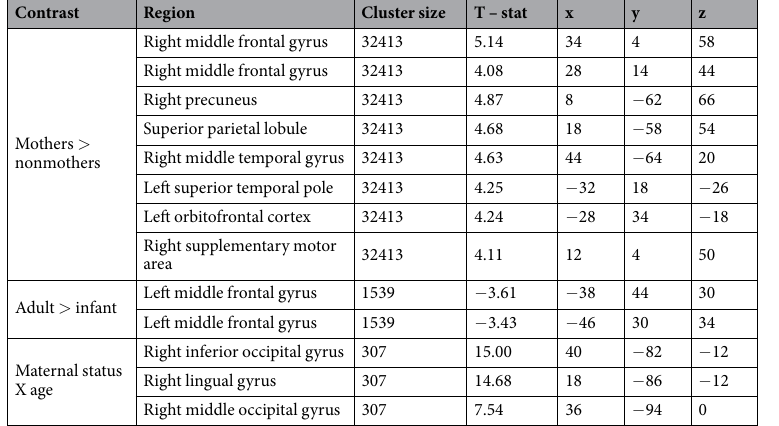
Table 3. Examining the effects of maternal status, stimulus age and their interaction across all participants (N = 58). Reporting peak MNI co-ordinates within clusters, applying cluster FWE correction (p < 0.05). Labelling of peaks within the larger significant clusters was done using the AAL2 atlas in bpsmview. Effects of infant age on maternal brain